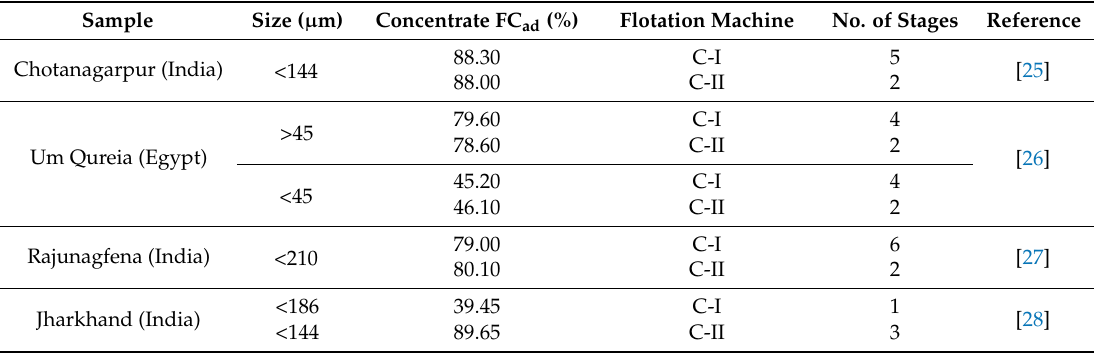
Table 1. Graphite flotation tests using a mechanical flotation cell and flotation